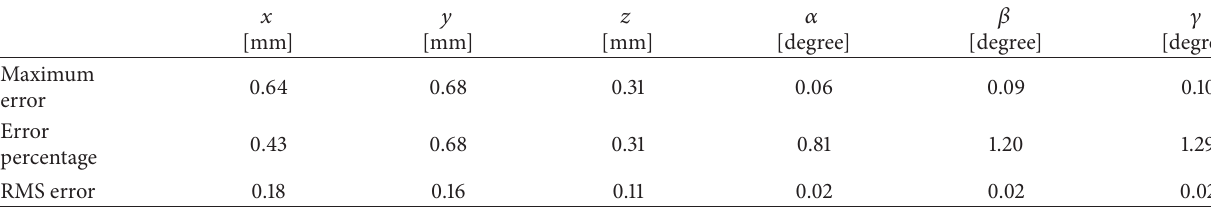
Table 6: Poses errors of the platform when adaptive-robust control is used.